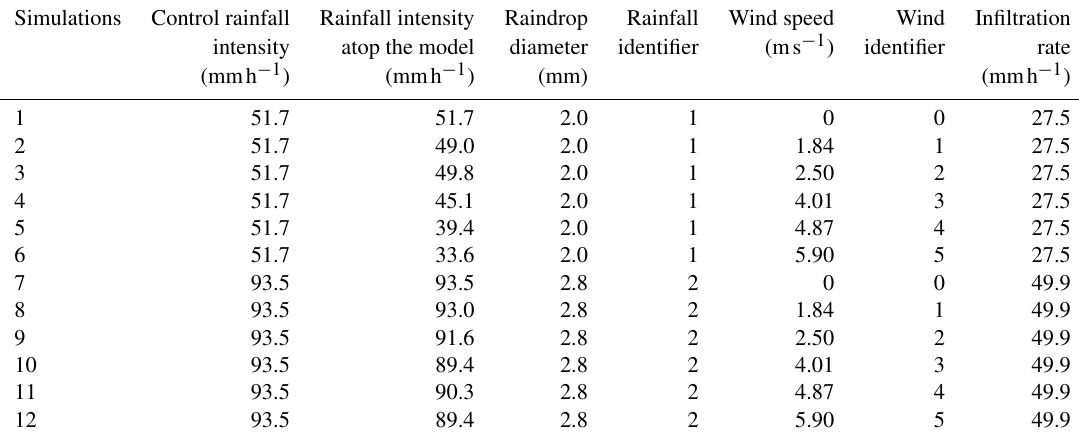
Table 1. The combinations of rainfall, wind speeds, and infiltration rates. Simulations Control rainfall Rainfall intensity Raindrop Rainfall Wind speed Wind Infiltration